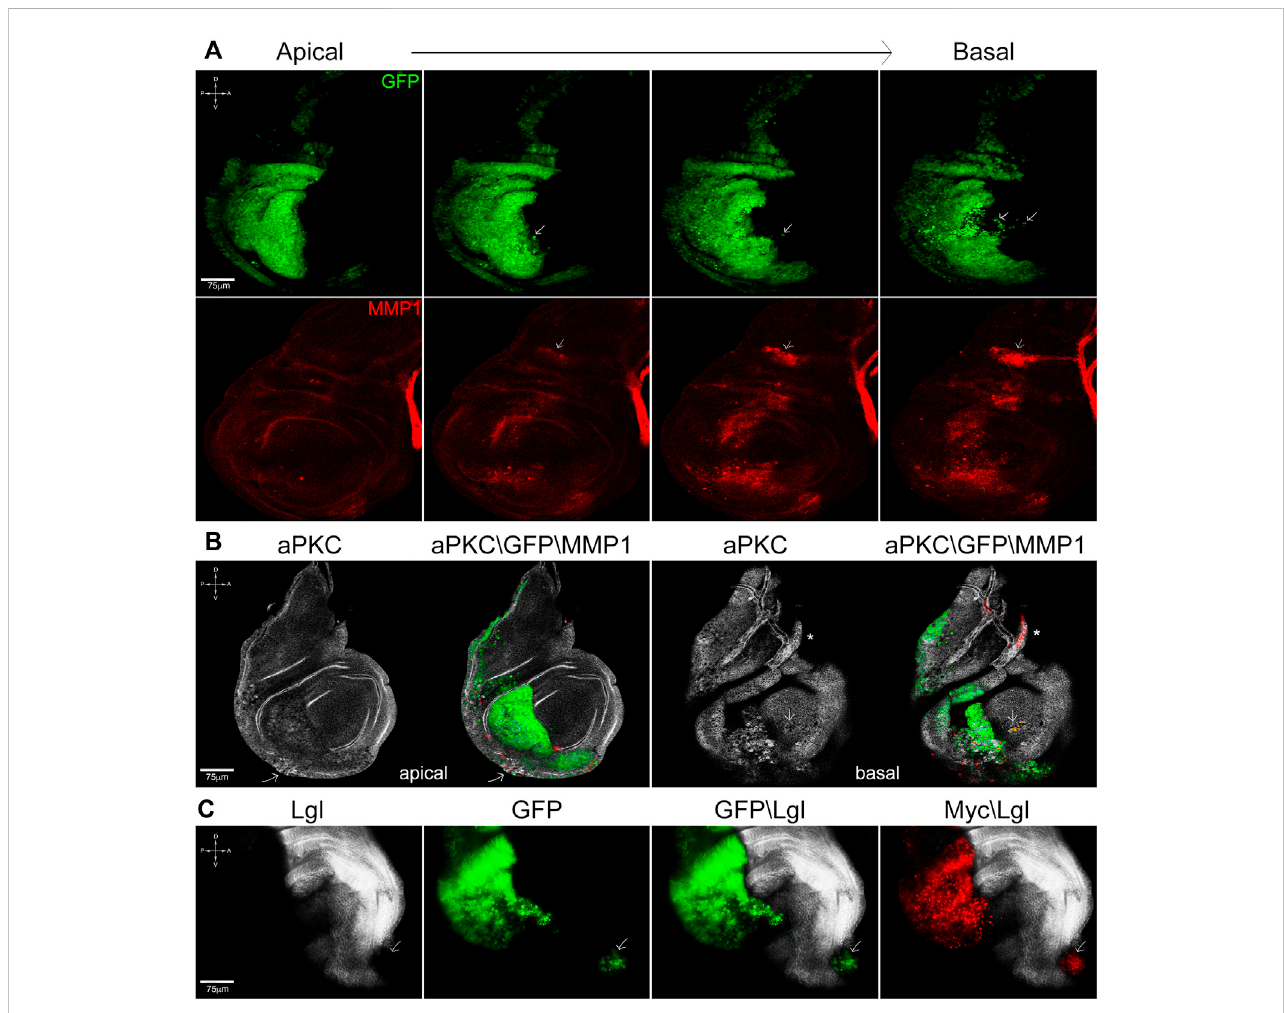
FIGURE 3 Cooperation between lgl knockdown and myc overexpression promotes cell migration and tissue disruption. (A) Apical-to-basal sections of en -lgl KD , myc OVER wing discs showing GFP + cells invading the anterior compartment (arrows) at the basal side of the disc epithelium. Cell migration is accompanied by MMP1 secretion (red), which also marks the air sac (arrow) and the tracheal tubes. (B) aPKC (white) and MMP1 (red) staining of en -lgl KD , myc OVER wing discs showing loss of tissue structure and focal MMP1 secretion (arrow) at the apical face and noticeable cell migration at the basal face (arrow). The asterisk marks the tracheal structure. (C) Lgl (white) and Myc (red) staining of en -lgl KD , myc OVER wing discs displaying local metastasis in the anterior compartment (arrow). See Supplementary Table S1 for plain genotypes. All the images represent disc cross-sections. Scale bars and A, p , D and V compartments are indicated for each